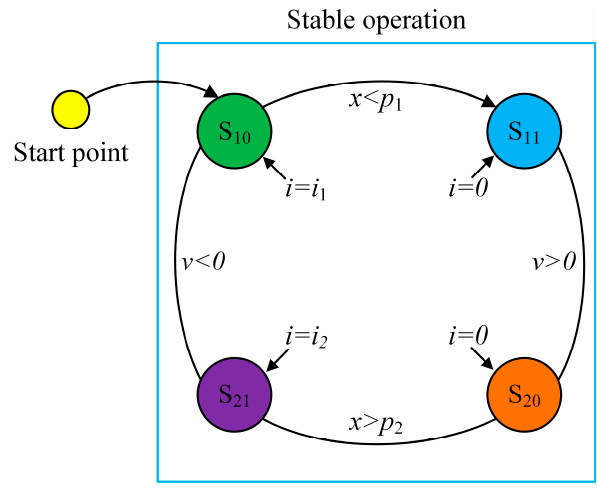
Figure 9. The finite-state machine (FSM) model for the LEM state switching.